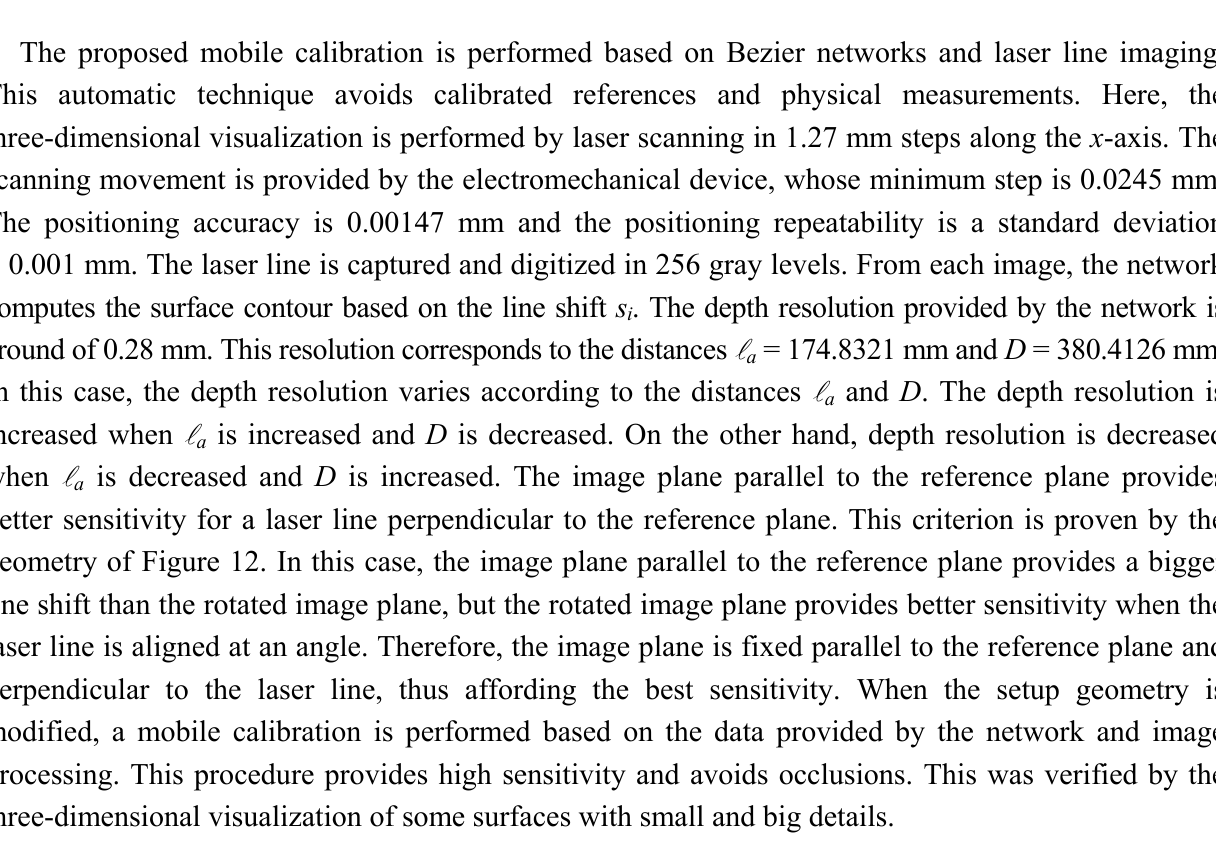
Figure 12. Geometry of an image plane parallel and not parallel to the reference